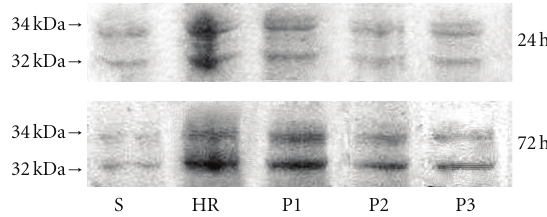
Figure 6: Western Blot analyses of AQP4. 32 and 34 kDa represent- ing the two AQP4 protein isoforms expressed in brain.